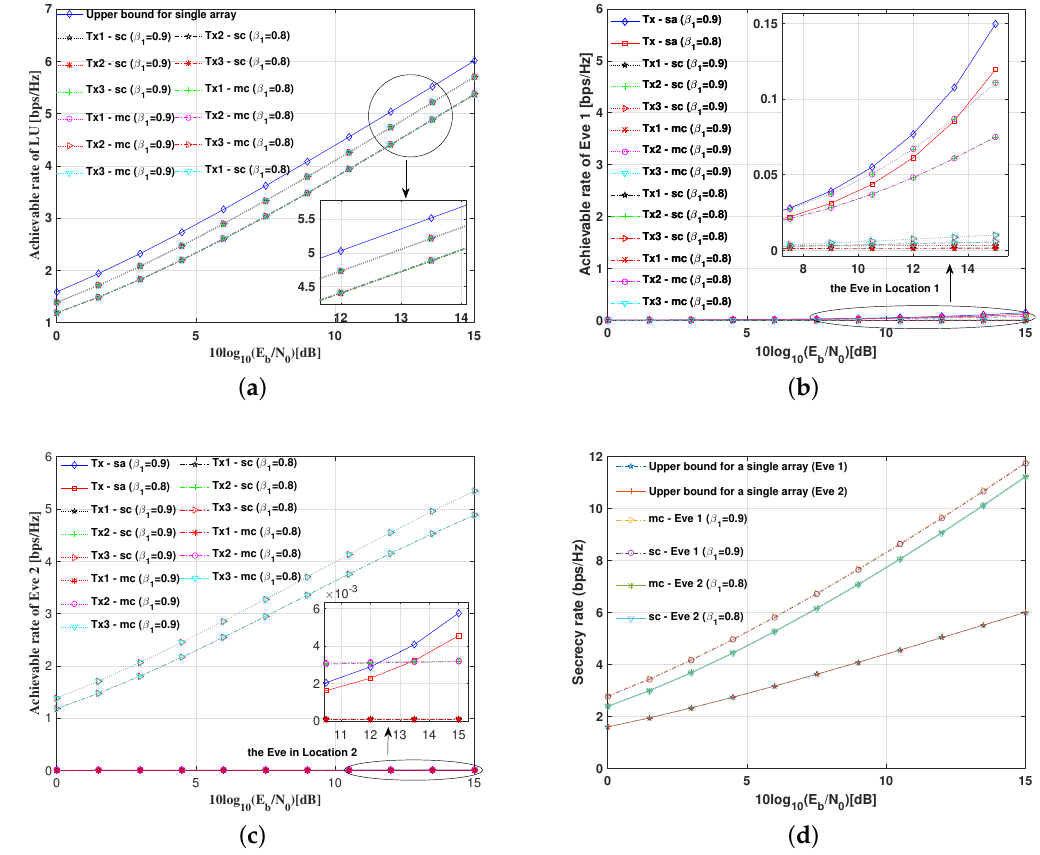
Figure 10. Achievable rate of the proposed DM schemes: ( a ) achievable rate of the LU versus SNR; ( b ) achievable rate of the Eve in Location 1 versus SNR; ( c ) achievable rate of the Eve in Location 2 versus SNR; and ( d ) secrecy rate performance of the proposed DM schemes.